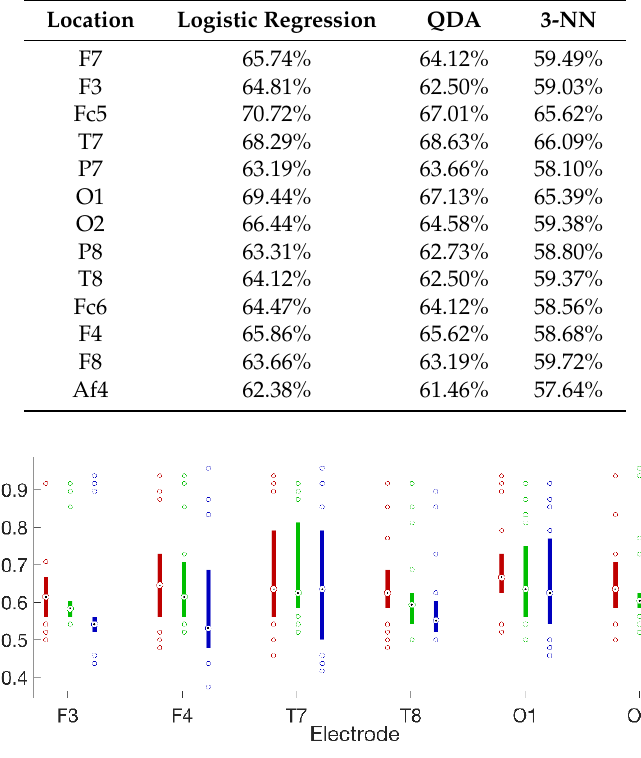
Figure 6. Box plots summarizing the distributions of classification accuracies across all 18 subjects for the logistic regression (red); quadratic discriminant analysis (green); and three-nearest neighbor classifiers (blue), on three laterally symmetric pairs of frontal (F3 and F4), temporal (T7 and T8), and occipital (O1 and O2) electrodes. Medians are shown as black dots inside colored circles and boxes span the interquartile range. Values falling outside the interquartile range are plotted as unfilled circles to explicitly show the number of subjects at the extremes of each distribution.